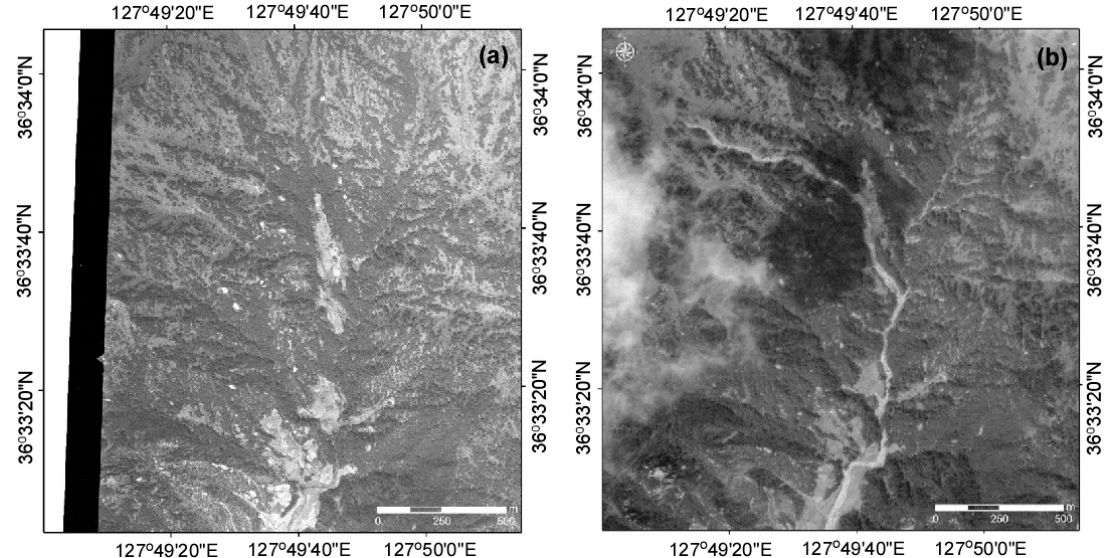
Figure 1. Landslides occurred in the study area in 1977 ( a ) and debris flow slides in 1984 ( b ).